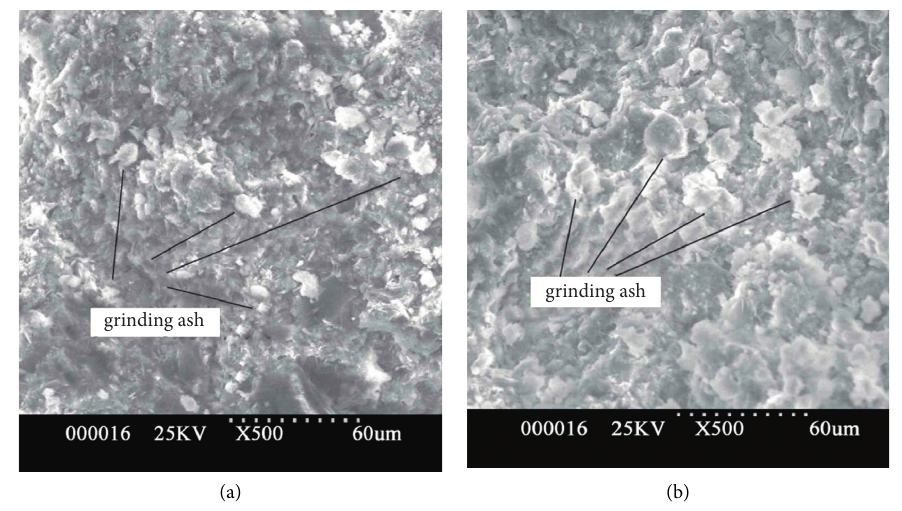
Figure 16: Micromorphology of GAC. (a) GAC1; (b) GAC3.